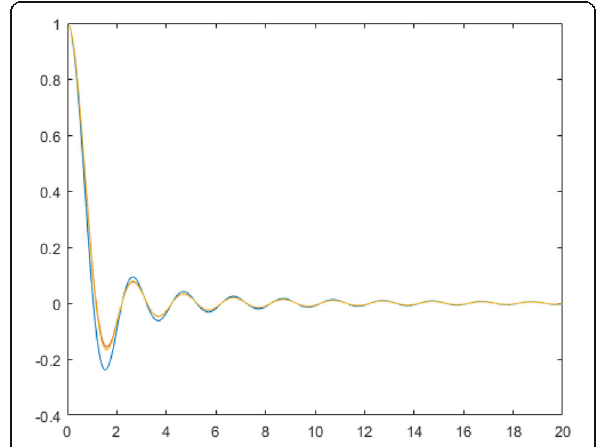
Fig. 6 The two-dimensional convolution kernel is only a function of radial distance r . The blue curve is for the conventional ramp filter. The yellow and orange curves (on the top of each other) are for the σ = 0.5: one is computed with the true H and the other is computed square-root function approximation